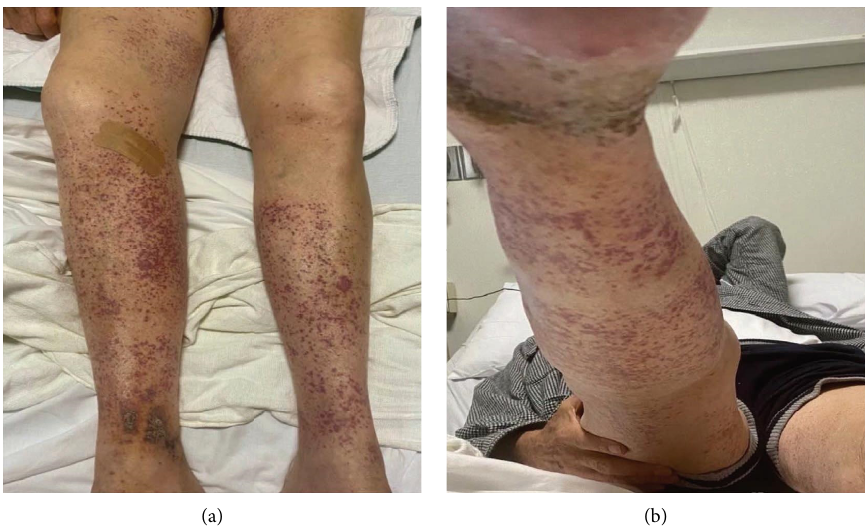
Figure 1: (a, b) Purpuric 1–3 macules located in the lower extremities extending to the anterior and medial